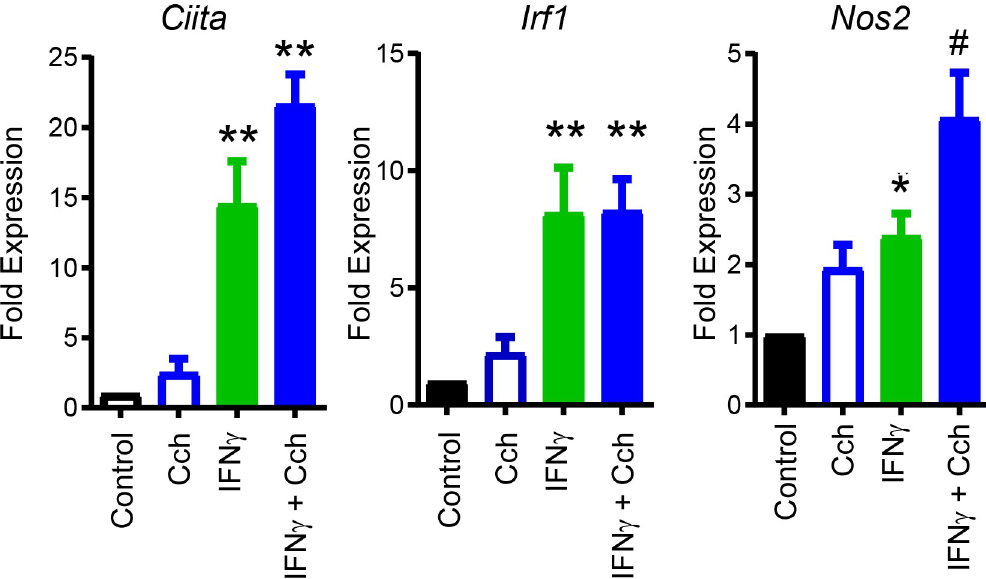
Fig 7. Nos2 expression induced by IFN γ in IEC is enhanced by cholinergic agonists. CMT-93 cells were stimulated with vehicle (control), Carbachol (‘Cch’ 100 μ M), IFN γ (1 ng/mL), or IFN γ (1ng/mL) + Cch (100 μ M) for 3h. Expression of IFN γ - induced genes Ciita, Irf1 and Nos2 was quantified by qRT-PCR. � , # P < 0.05, �� P < 0.01, ANOVA, n = 4 independent experiments.